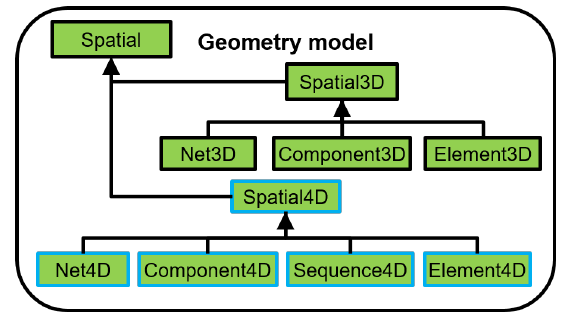
Figure 3. New class-hierarchy of geometry-package (allows